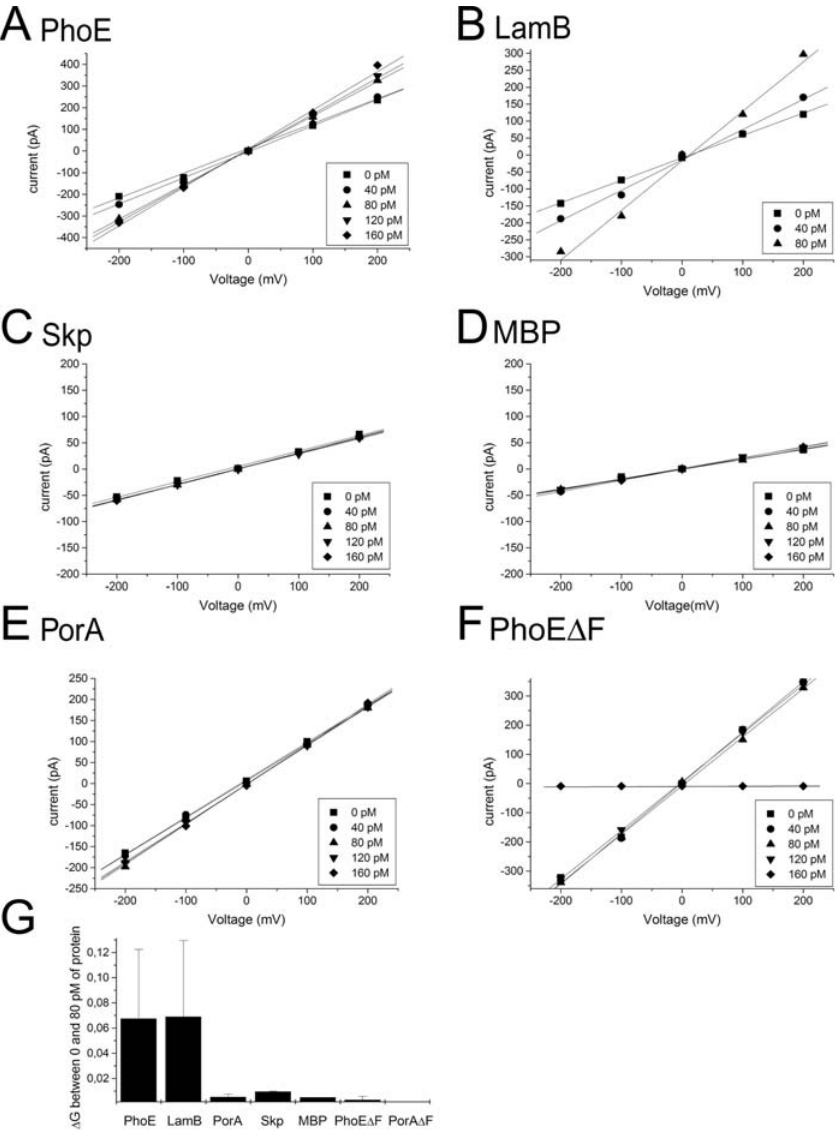
Figure 4. Denatured OMPs Affect Omp85 Pore Activity (A–F) Voltage ramps were applied to bilayers containing several Omp85 channels before and after the addition of the proteins indicated above the panels. The amounts of protein added are shown in the inserts. The numbers of active 0.12-nS Omp85 channels in the experiments depicted were 10,